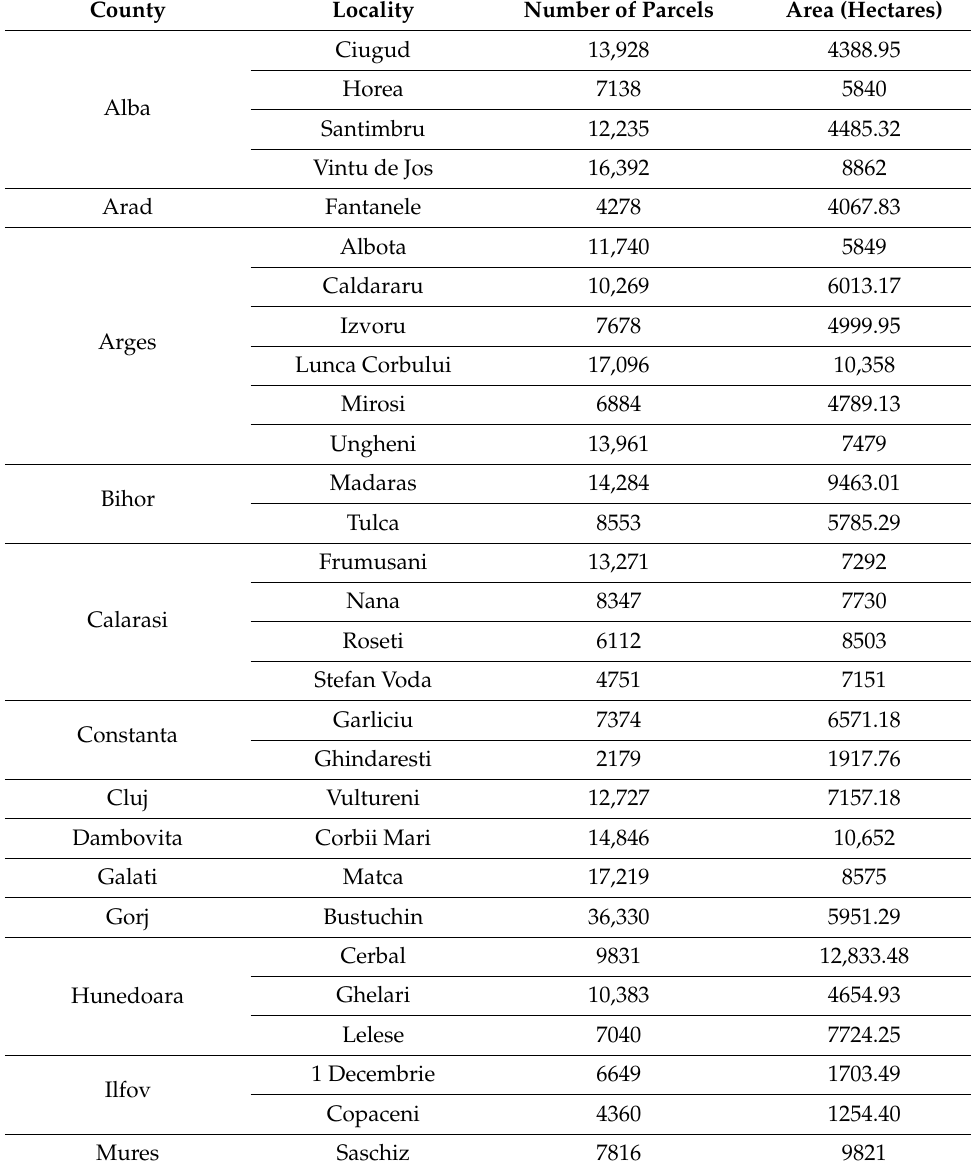
Table 1. Localities used for quantitative study for the principle of aerial images rather than field